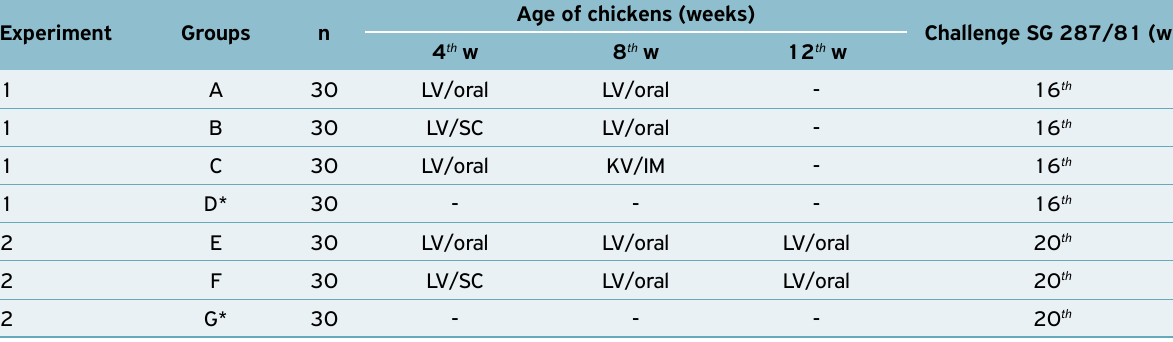
Table 1. Vaccination schemes using two or three doses.